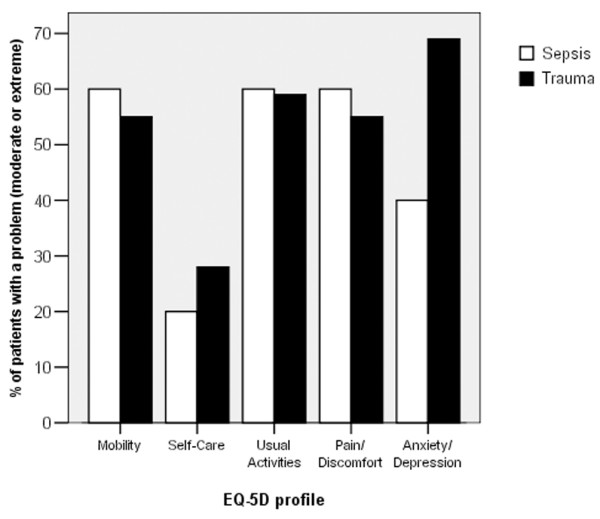
EuroQol 5D profile after 2 years. The EuroQol 5D profile is dichotomized into 'no problems' and 'moderate/extreme problems'. After 2 years there was no significant difference between the sepsis group and the trauma group.